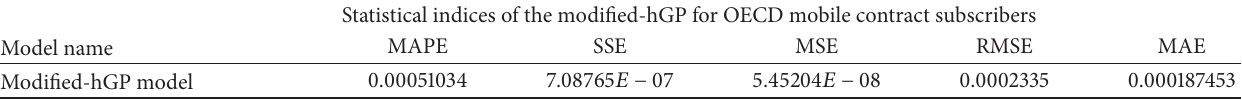
Table 3: Statistical indices in fitting process of the modified-hGP model for the OECD mobile contract subscribers. Statistical indices of the modified-hGP for OECD mobile contract subscribers